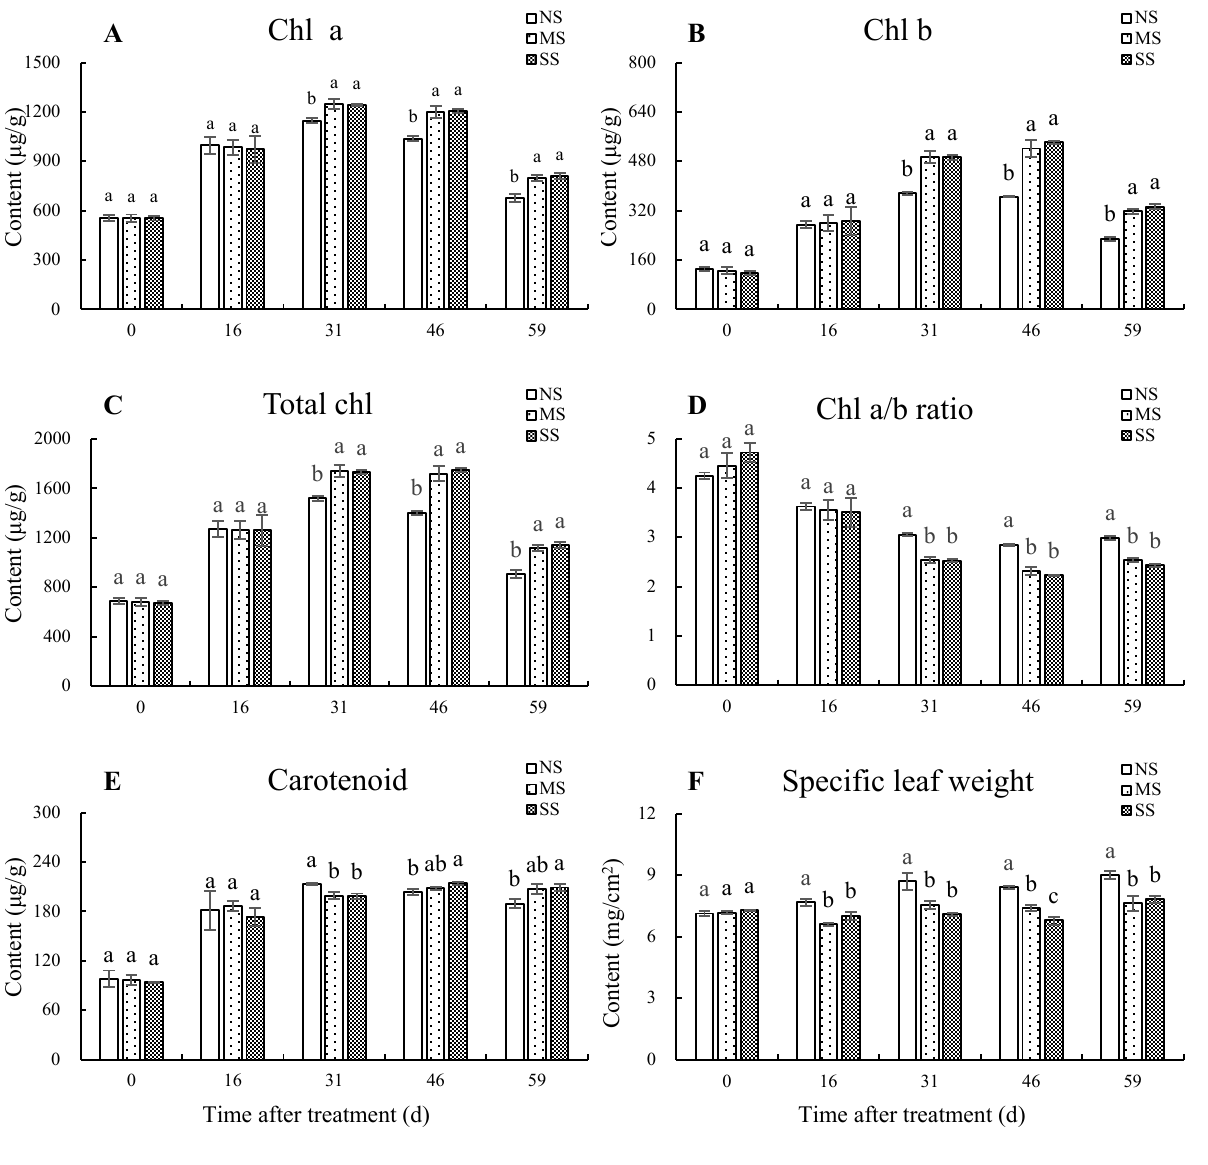
Figure 1. Dynamic changes in photosynthetic pigments and specific leaf weight. ( A ) Chl a content. ( B ) Chl b content. ( C ) Total chl content ( D ) Chl a/b ratio. ( E ) Carotenoid content. ( F ) Specific leaf weight. Total chl content = chl a content + chl b content, Chl a/b ratio = chl a content/chl b content. Values are means of three replicates ± SD and different letters indicate significant differences (Duncan ′ s multiple range tests, p < 0.05) among three treatments at the same developmental stage.